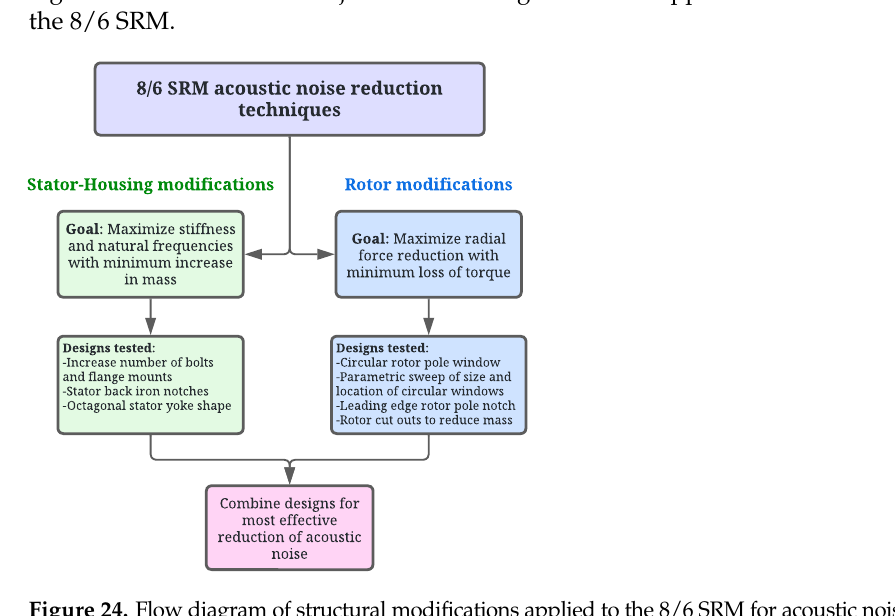
Figure 24. Flow diagram of structural modifications applied to the 8/6 SRM for acoustic noise reduction.